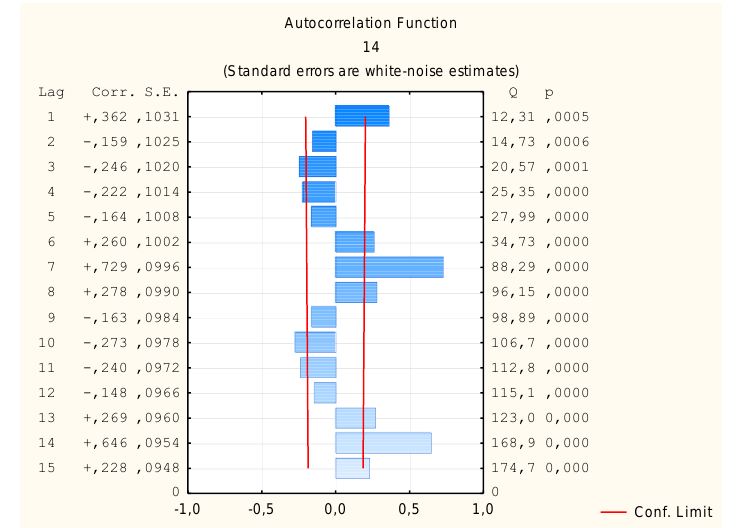
Fig. 7. Autocorrelation function of passenger flows of bus route №85.